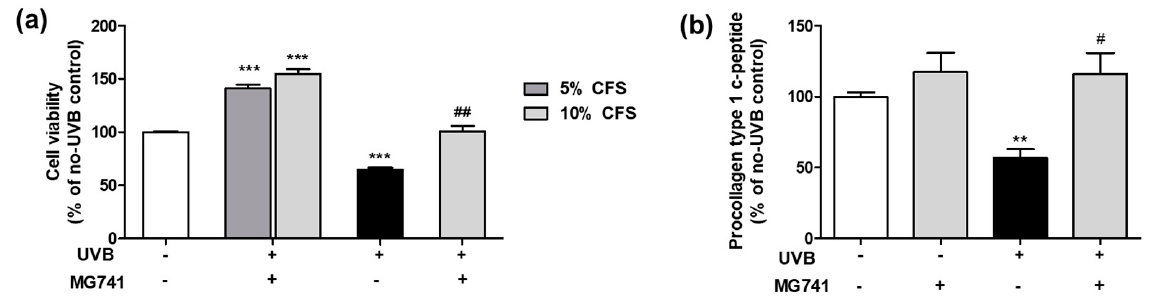
Figure 2. Effects of CFS from Bi. lactis MG741 on ( a ) cell viability and ( b ) procollagen type 1 c-peptide (PIP) contents in UVB-exposed Hs68 fibroblasts. Data are indicated as means ± standard error (SE, n = 3). ** p < 0.01, and *** p < 0.001 vs. no-UVB control; # p < 0.05, and ## p < 0.01 vs. UVB-exposed control.